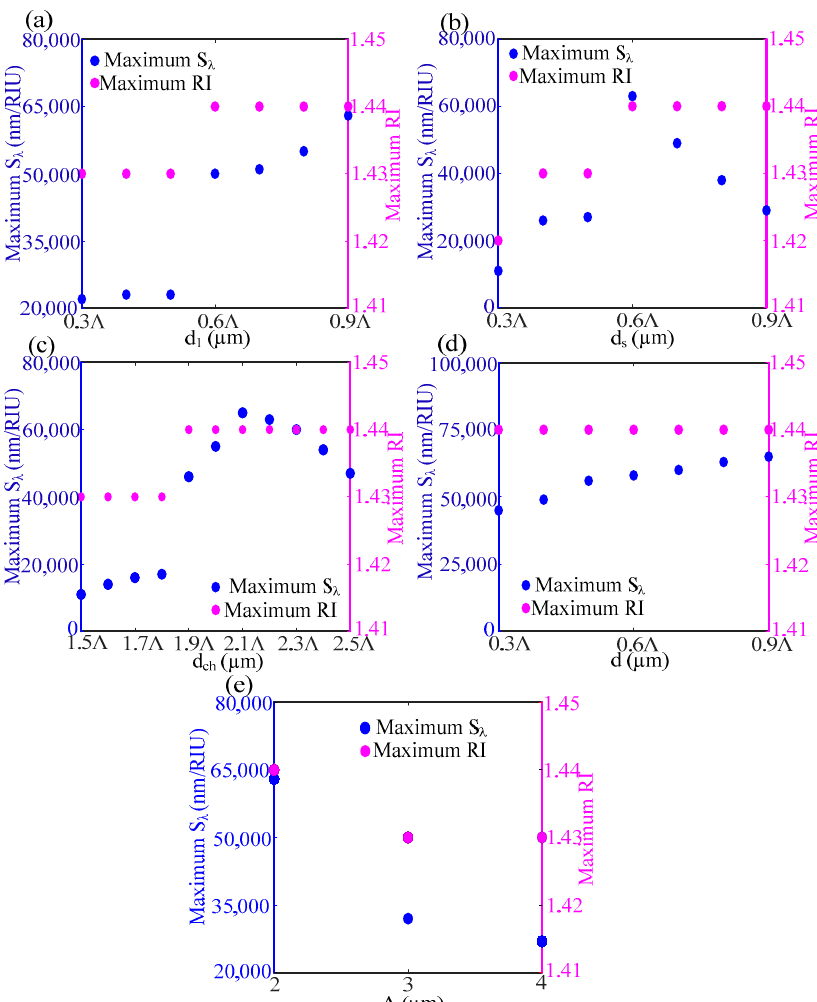
Figure 8. Effect of ( a ) air-hole diameter d 1 , ( b ) air-hole diameter d s , ( c ) outer-channel diameter d ch , and ( d ) air-hole diameter d, and ( e ) pitch on maximum wavelength sensitivity and sensing range.